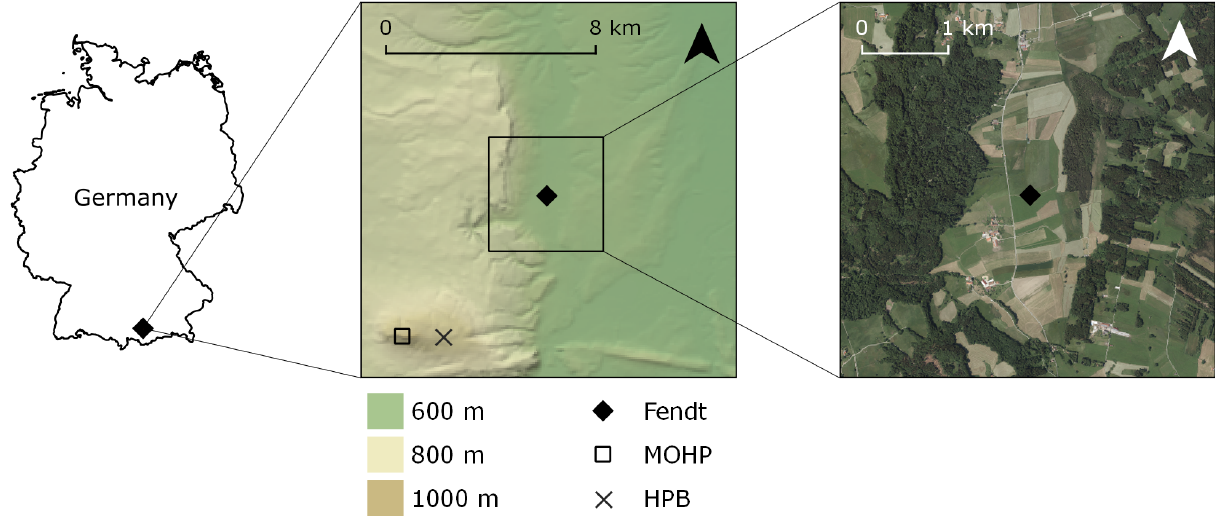
Figure 1. Location, topography and aerial image of the Fendt site and its surroundings. MOHP is the Meteorological Observatory Hohen- peißenberg, and HPB is the ICOS station Hohenpeißenberg. Digital elevation model and aerial imagery by Bayerische Vermessungsverwal- tung, https://www.geodaten.bayern.de (last access: 25 March 2020).